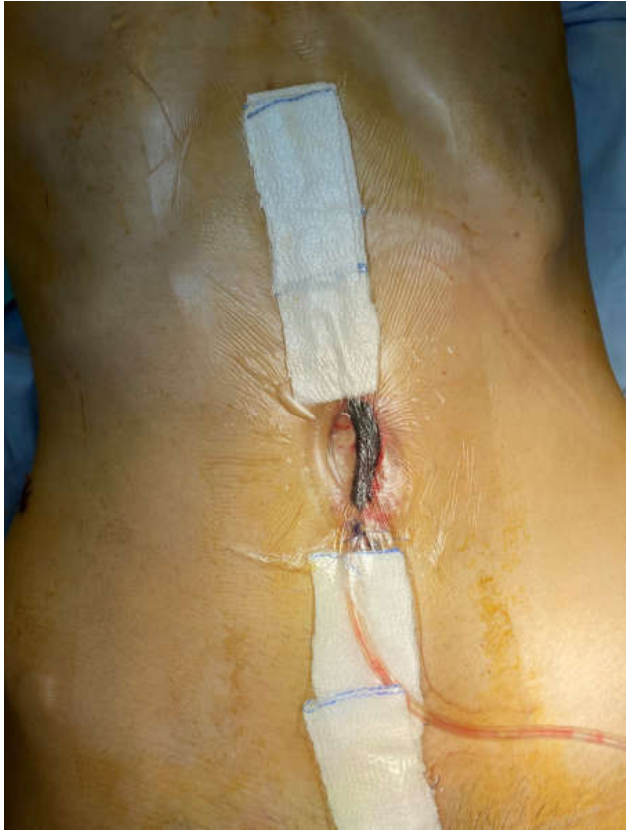
Figure 5. Upper and lower staged closure of the skin, NPWT at the site of the EAF (6 days after the start of treatment).